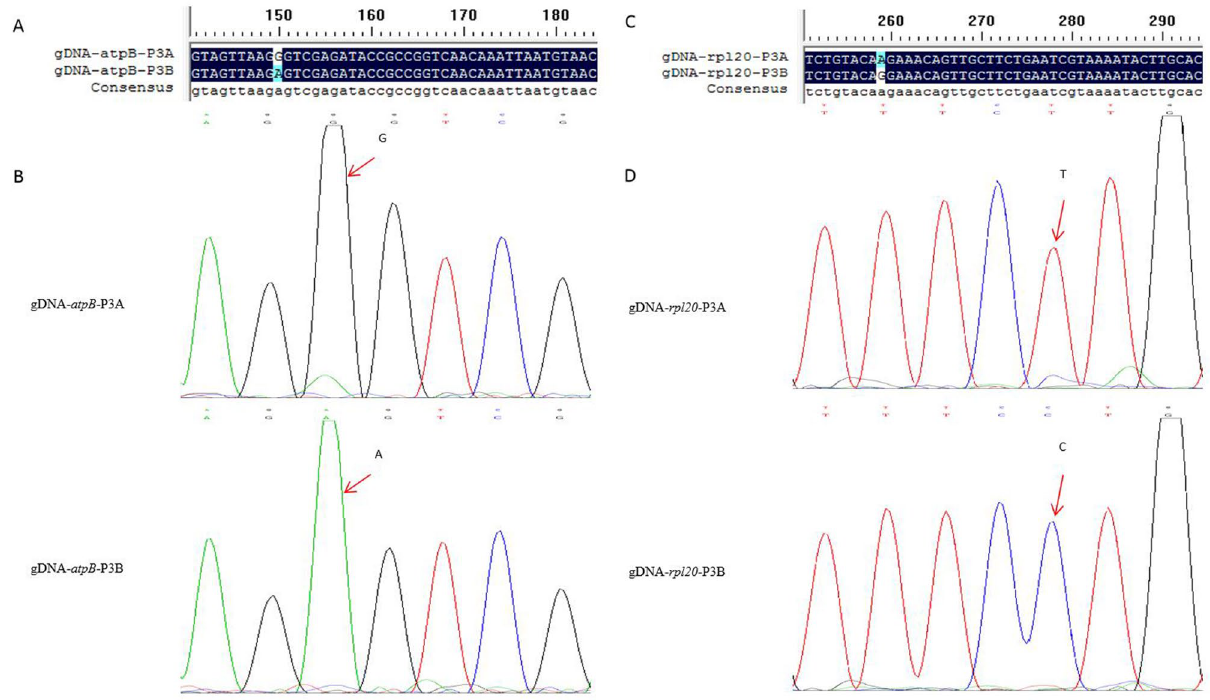
Figure 9. Cloning and sequencing results of atpB and rpl20 . DNAMAN (V6.0.3.99 version) and PPT software were used for graph